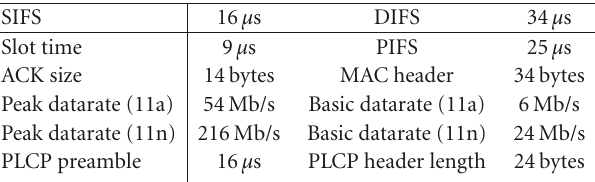
Table 4: PHY/MAC parameters used in the